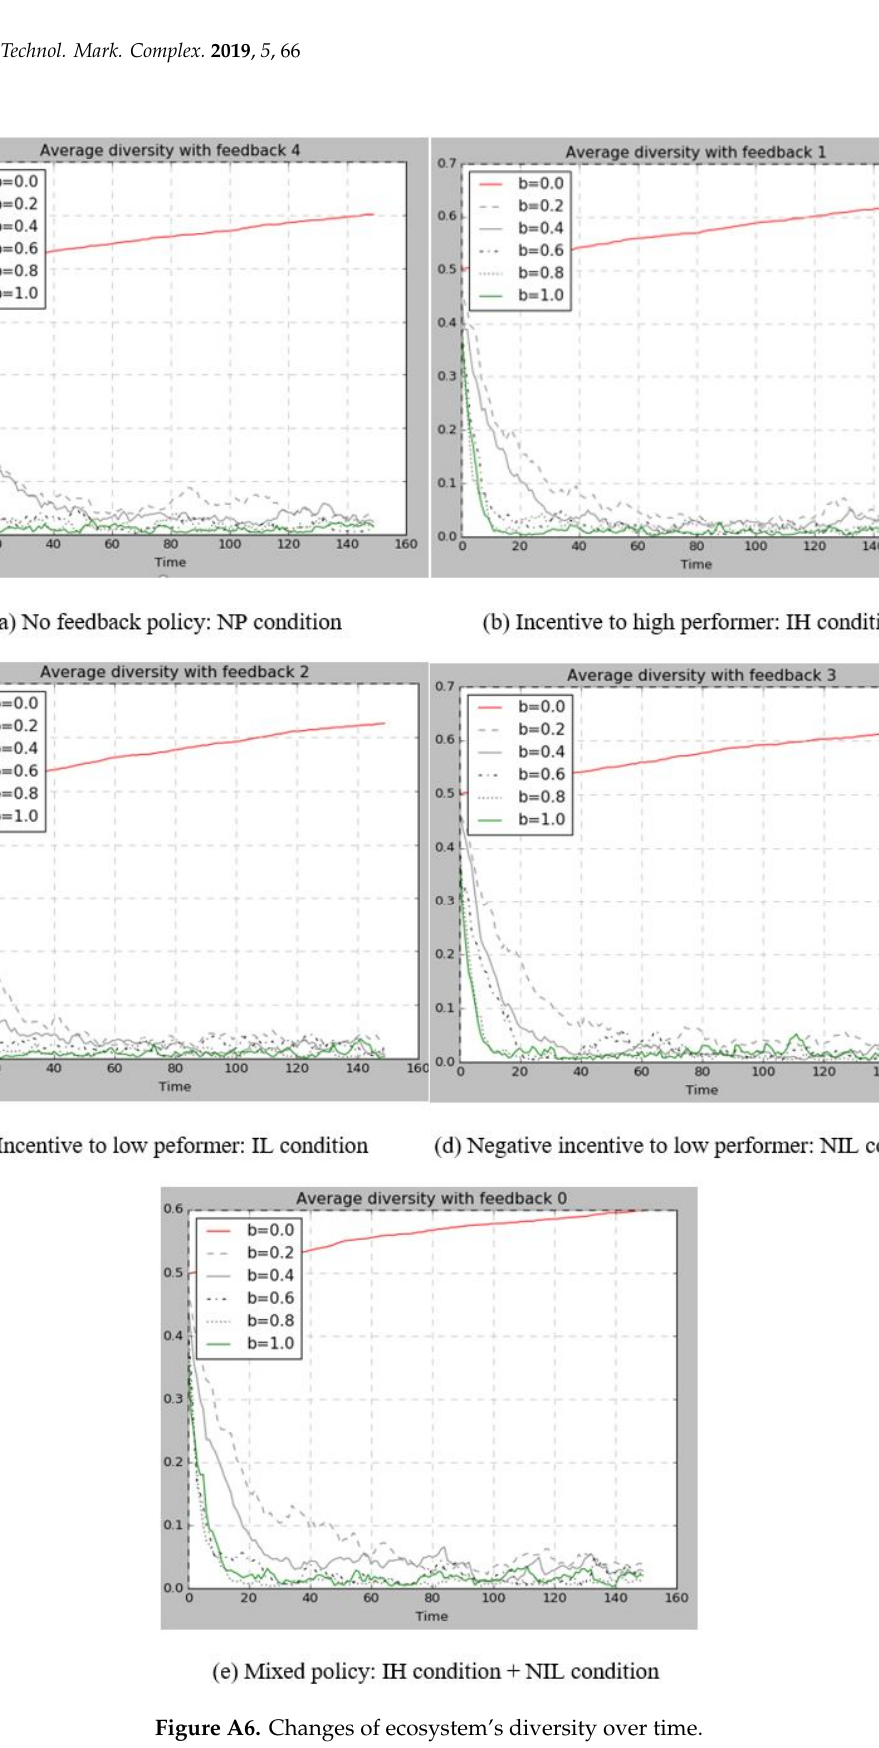
Figure A6. Changes of ecosystem’s diversity over time.